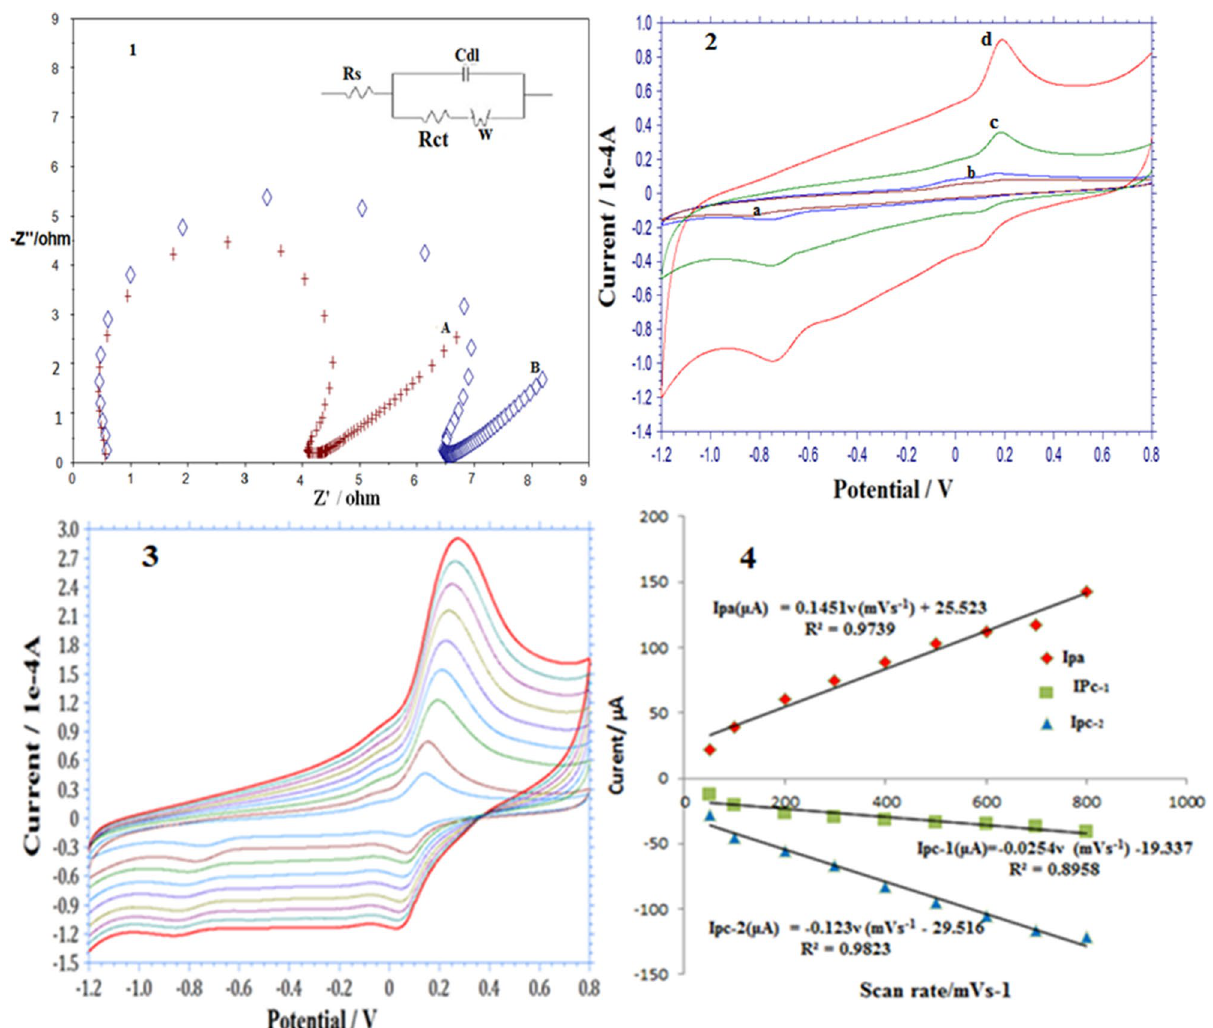
Figure 6. (1) Nyquist-plots for ( A ) GN:ZnO NC modified GCE and ( B ) GN modified GCE in 0.1 M KCl solution in presence of 1.0 mM each of Fe[(CN) 6 ] −3 and Fe[(CN) 6 ] −4 (1:1). Insert: Equivalent circuit for fitting the Nyquist-plot. (2) CV of ( a ) phosphate-buffer at pH 6.8 (blank) at bare GCE and 1.96 × 10 –6 M p-NP in phosphate buffer at pH 6.8. ( b ) Bare GCE, ( c ) GN:GCE and ( d ) GN:ZnO NC modified GCE, Scan rate100 mVs −1 . (A) Effect of scan-rate on peak current of p-NP (1.96 × 10 −6 M) using cyclic voltammetry at 50, 100, 200, 300, 400, 500, 600, 700, 800 mVs −1 using GN:ZnO NC/GCE. ( B ) Plots of peak current (I pa , I pc ) vs. potential scan rate (v).